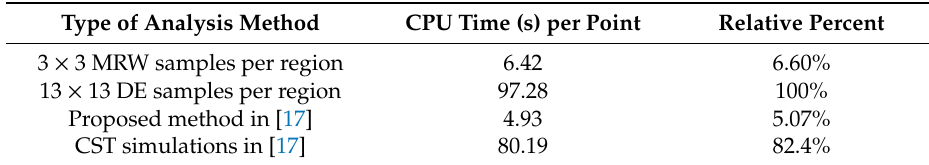
Table 3. CPU time consumption required per point of the phase curves of ∠ R RHCP,RHCP and ∠ R LHCP,LHCP for results shown in Figure